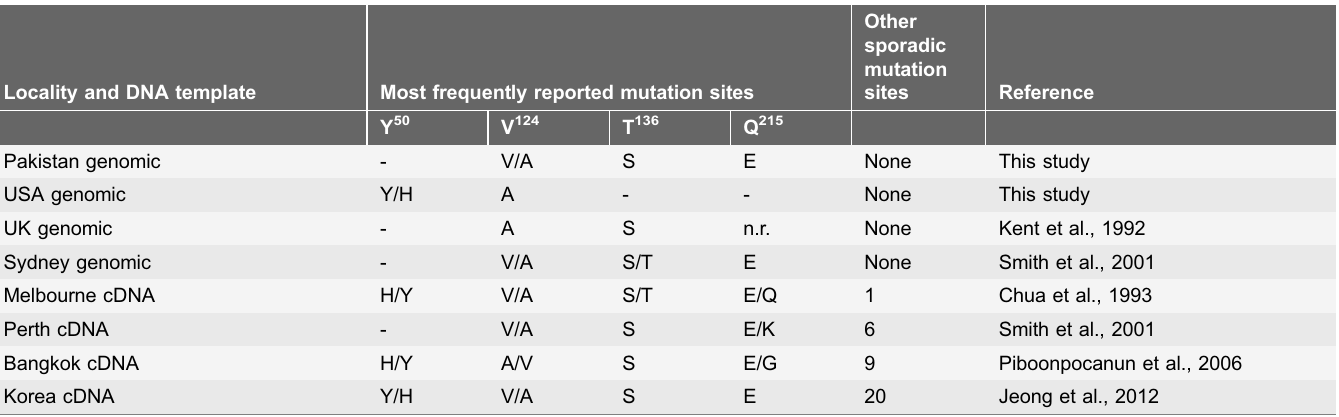
Locality and DNA